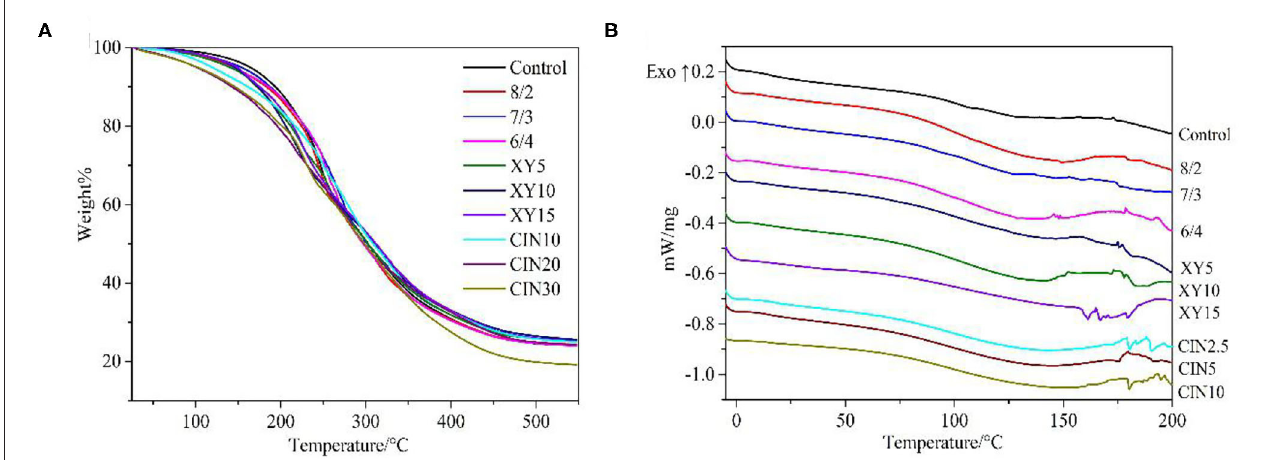
FIGURE 5 | (A) Thermogravimetric analysis (TGA) and DSC (B) curves of GP-based composite films.